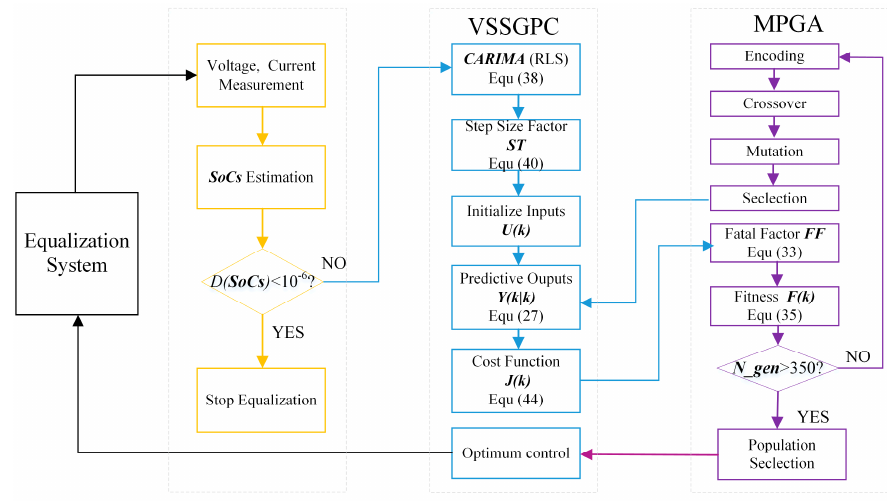
Figure 6. Flow chart of